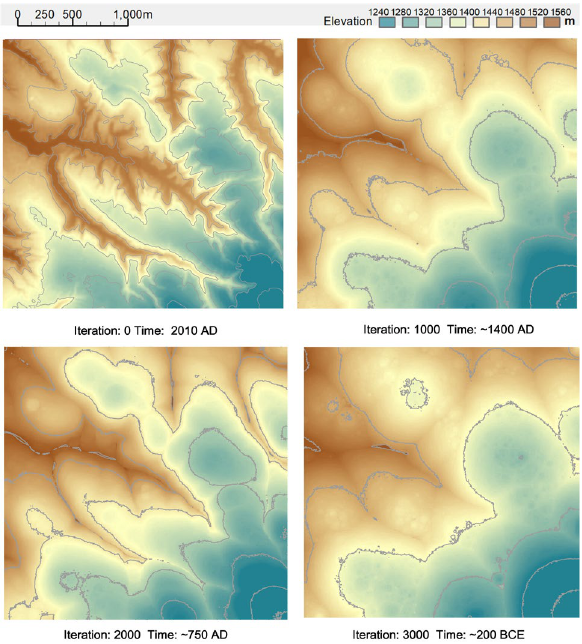
Figure 6. CA simulation